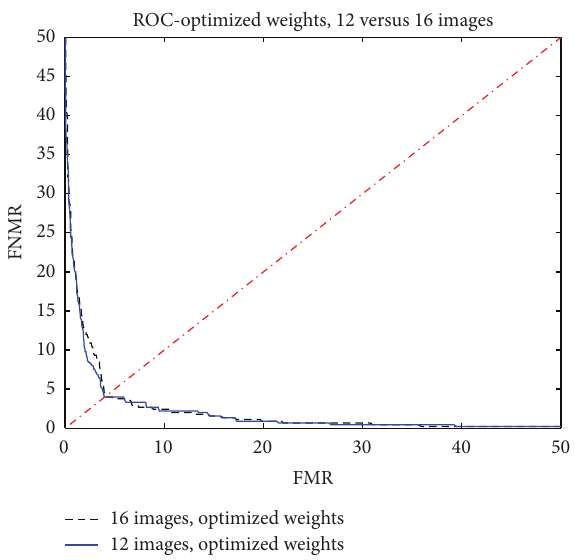
Figure 12: ROC function with 12 images versus 16 images with optimized